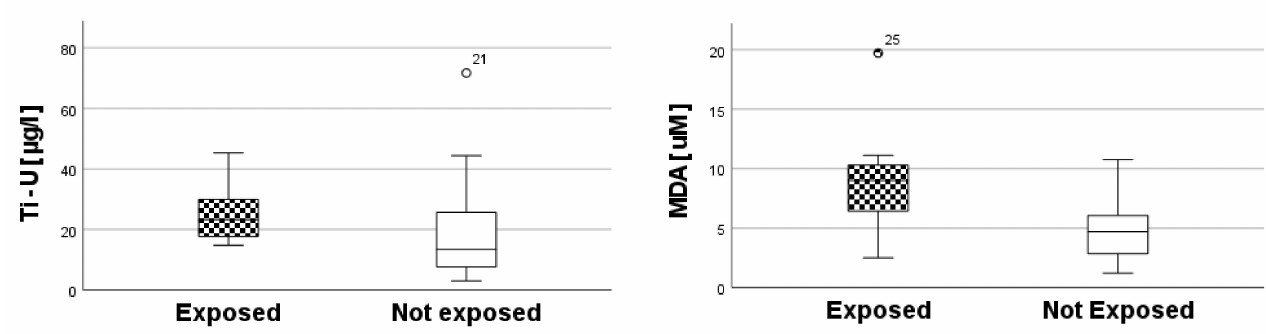
Figure 3. Differences in exposed vs. not exposed of Ti and MDA, as biomarkers of exposure and oxidative stress, respectively.